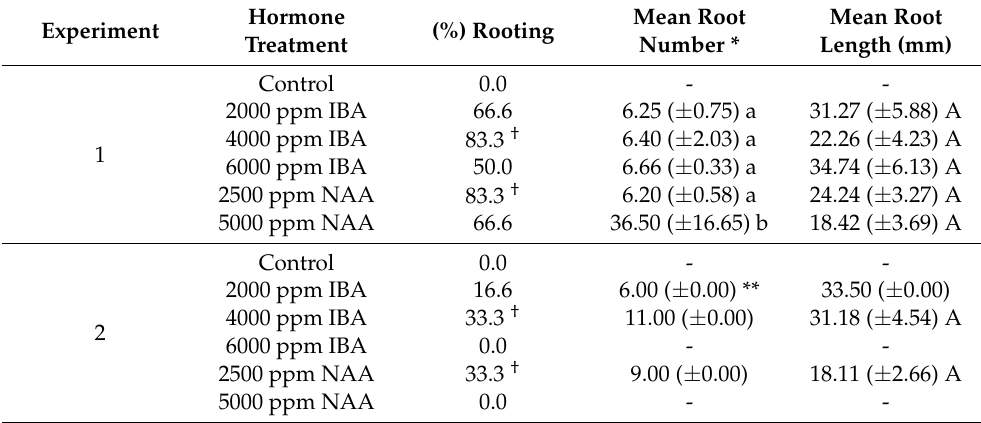
Table 1. Overview of the rooting results for A. ovalis subsp. ovalis genotype GR-1-BBGK-04,2547 with rooting frequencies and the corresponding rooting attributes in terms of root number and average root length ( ± SEM, p < 0.05) of the rooted cuttings for each hormone treatment in the two experiments conducted in 2020. Cuttings in both experiments were leafy soft-wood sections of primary stem growth with cuttings for the second experiment having a more advanced level of lignification. Rooting conditions were under automated mist within a greenhouse at ambient temperature and relative humidity (RH) was maintained at >85%. None of the combinations of hormone treatment and pre-treatment were successful. Thus, only the results from treatments under which cuttings managed to root in either of the two experiments are shown. The control treatments (i.e., no hormone treatment or pre-treatment application), failed to root in both experiments. Hormone Experiment Treatment